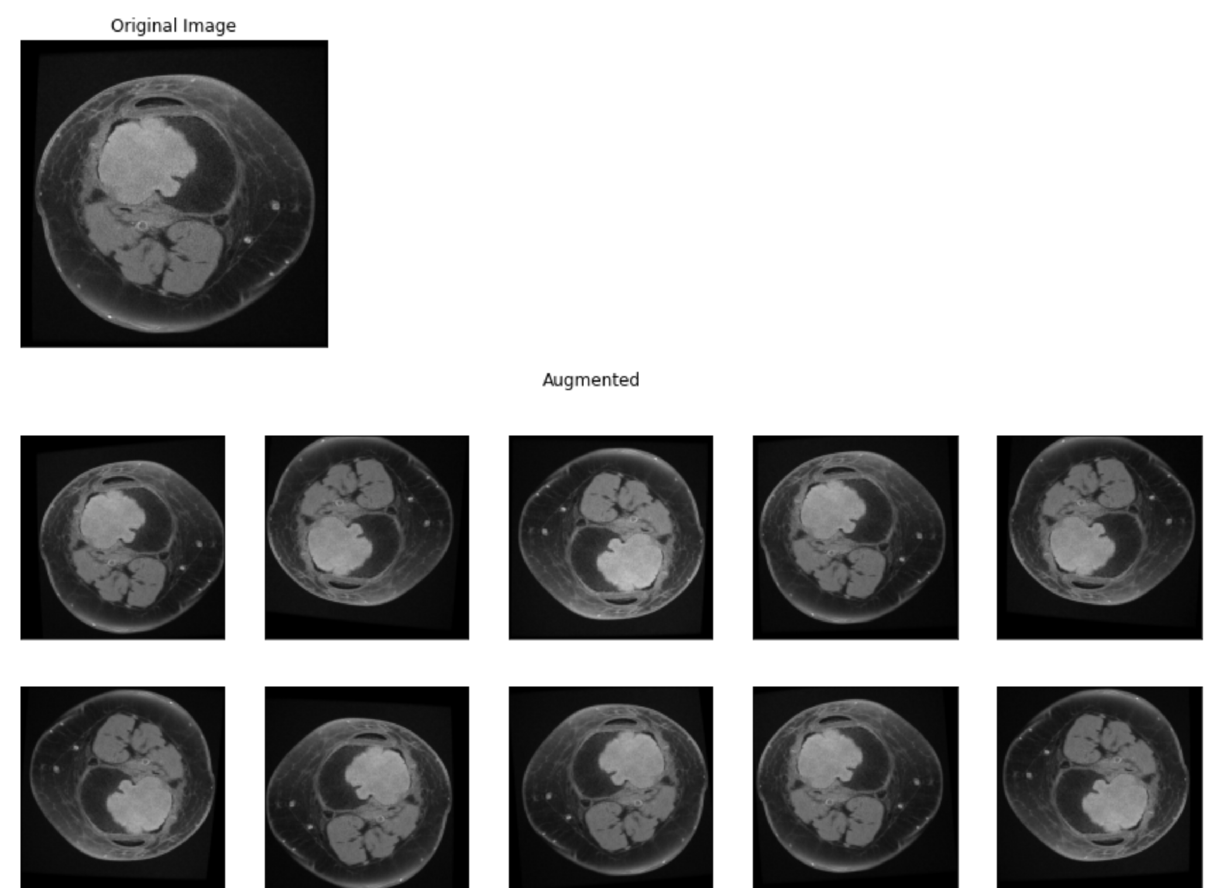
Figure 2. Data augmentation. Original sample and augmented samples.